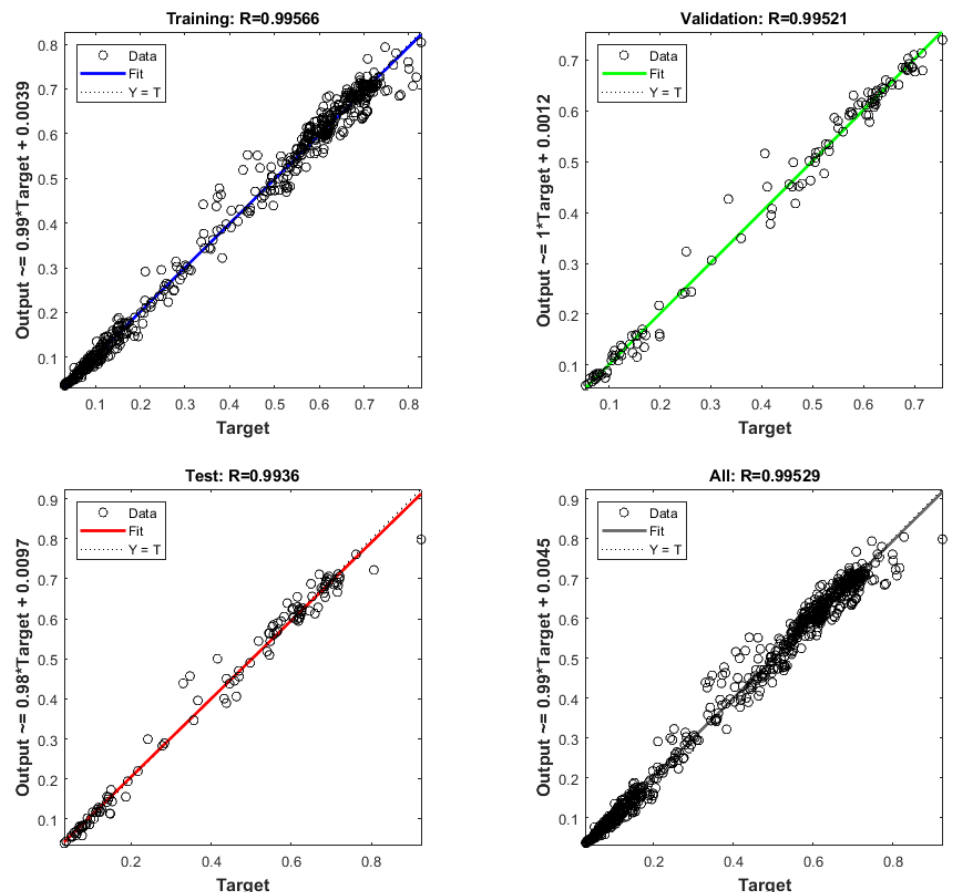
Figure 11. Performance analysis of the predicted LRN model.